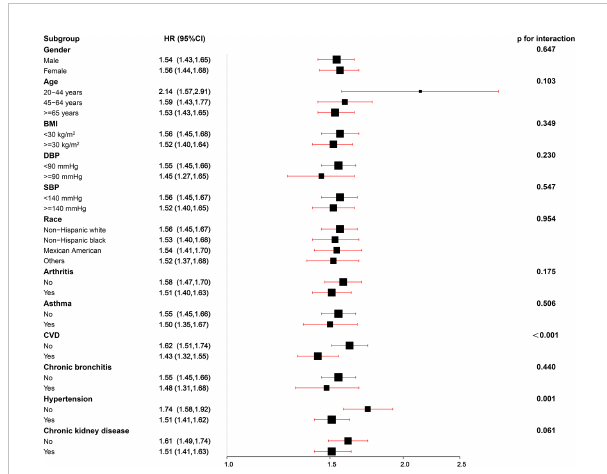
FIGURE 3 Strati fi ed analyses of the associations (hazard ratios, 95% CIs) between ePWV values and all-cause mortality in patients with DM. HRs were fully adjusted by the following covariates including age, systolic blood pressure, diastolic blood pressure, gender, race, poverty income ratio, body mass index, waist, glycated hemoglobinA 1c , total physical activity, creatinine, estimated glomerular fi ltration rate, total cholesterol, high-density lipoprotein cholesterol, cardiovascular diseases, chronic kidney disease, diabetes mellitus, chronic bronchitis, hypertension, arthritis, antihypertensives and glucose-lowering drugs, smoking,